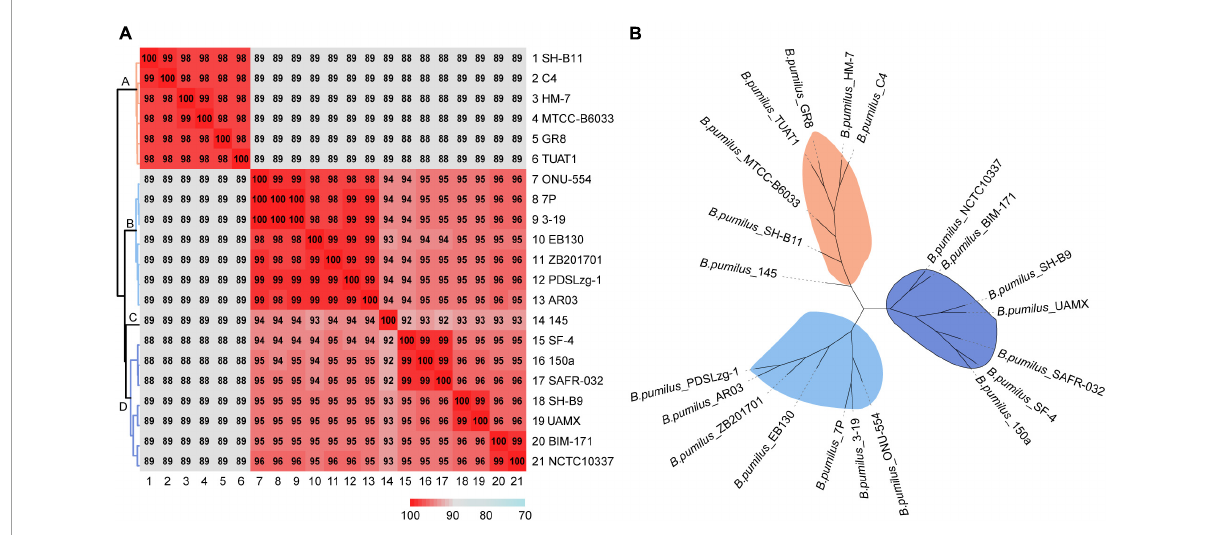
FIGURE4 Evolutionary relationships of 21 strains of B. pumilus . (A) Heatmap and dendrogram of average nucleotide identity among different strains. (B) Phylogenetic tree based on total single-copy orthologous.